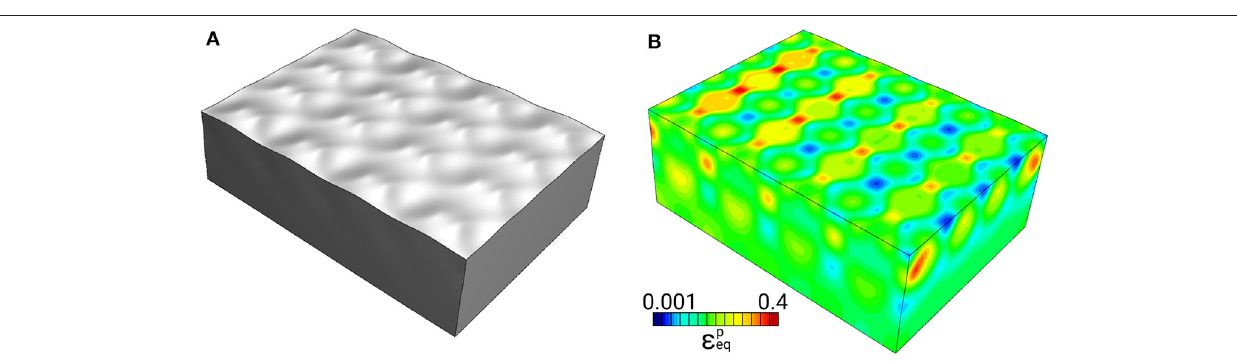
FIGURE 9 | Roughness pattern (A) and plastic strain field (B) in the model shown in Figure 8A at 20% tensile